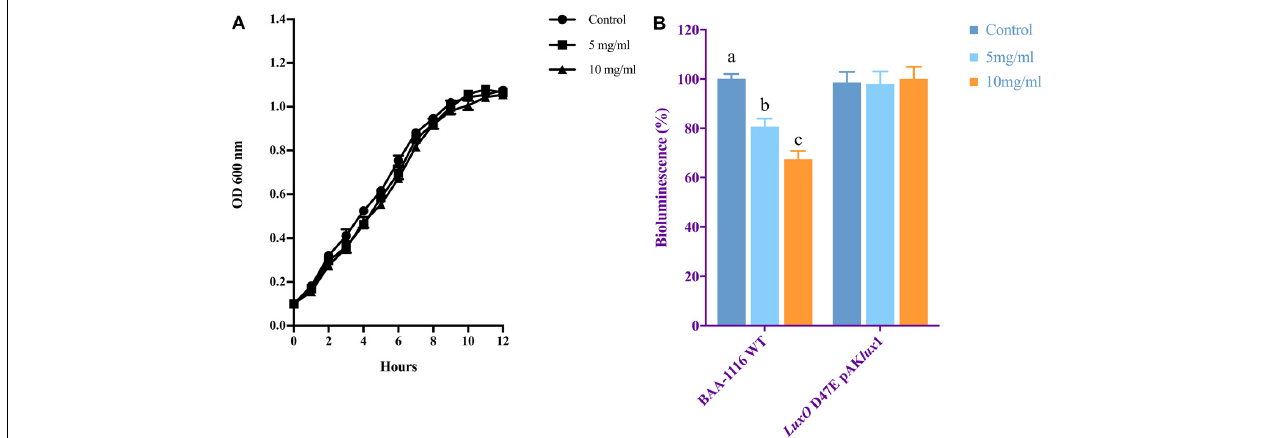
FIGURE 2 | (A) Growth of V. campbellii treated with 5 and 10 mg ml − 1 NaAs compared with untreated culture. The growth curves were determined for three independent cultures. (B) Impact of 5 and 10 mg m − 1 NaAs on bioluminescence of V. campbellii wild type BAA-1116 and mutant LuxO D47E containing plasmid pAKlux1, in which bioluminescence is independent of quorum sensing. For each strain, bioluminescence in the control treatment was set at 100% and other treatments were normalized accordingly. The error bars represent the standard deviation of three replicates. Different letters indicate significant differences (One-way ANOVA with Duncan’s post hoc test, P < 0.01).